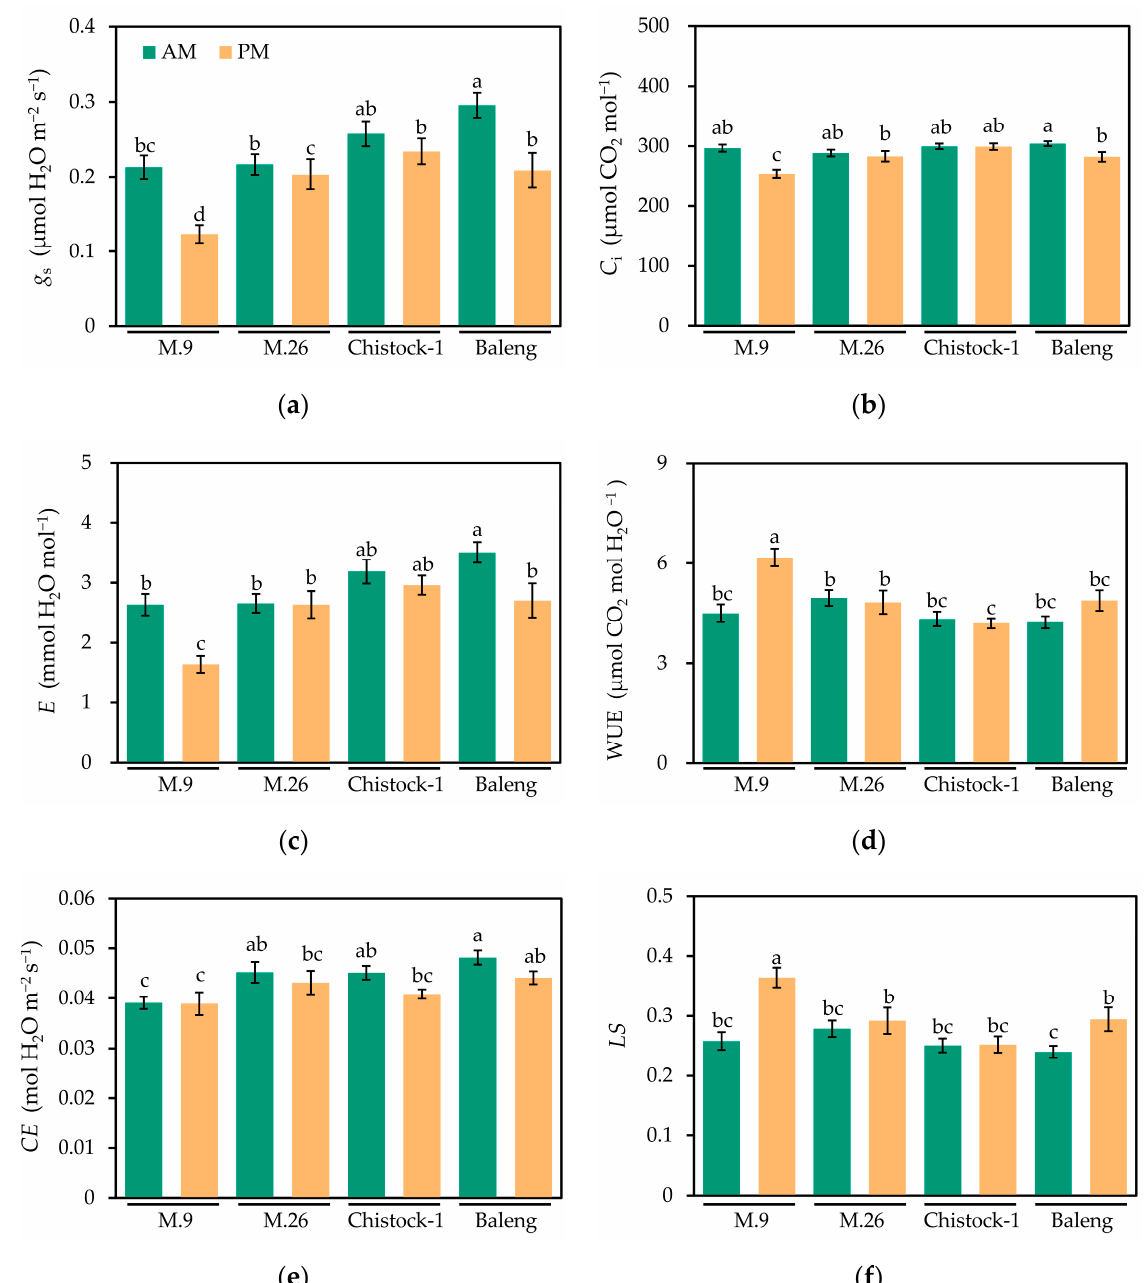
Figure 6. Parameters related to gas exchange of ‘Red Fuji’ scion leaf influenced by rootstocks in the morning (AM) and afternoon (PM). ( a ) Stomatal conductance ( g s ); ( b ) intracellular CO 2 concentration ( C i ); ( c ) transpiration rate ( E ); ( d ) water-use efficiency (WUE); ( e ) leaf carboxylation efficiency ( CE ); ( f ) stomatal threshold ( LS ). Parameters were measured on the same functional leaves. Columns are means of data (at least eight replications) ± standard error (SE) bars. Different letters after mean values ± standard error in the same column indicate the significant difference determined by the least significant difference (LSD) test with p < 0.05.